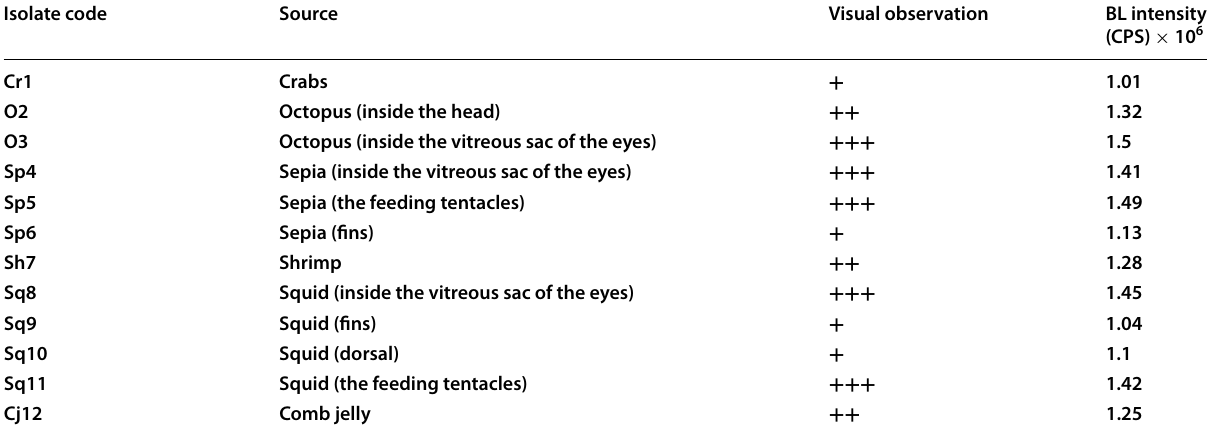
Degree of bioluminescence: strong (